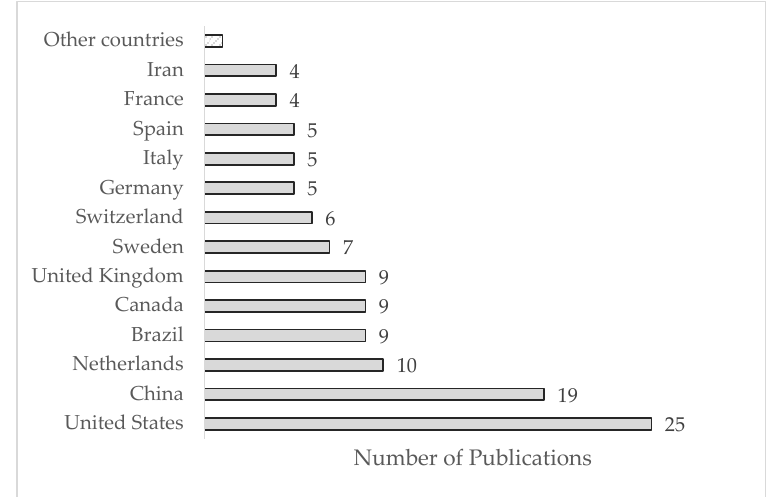
Figure 4. Contributions from different countries from 2019 to August 2022 .